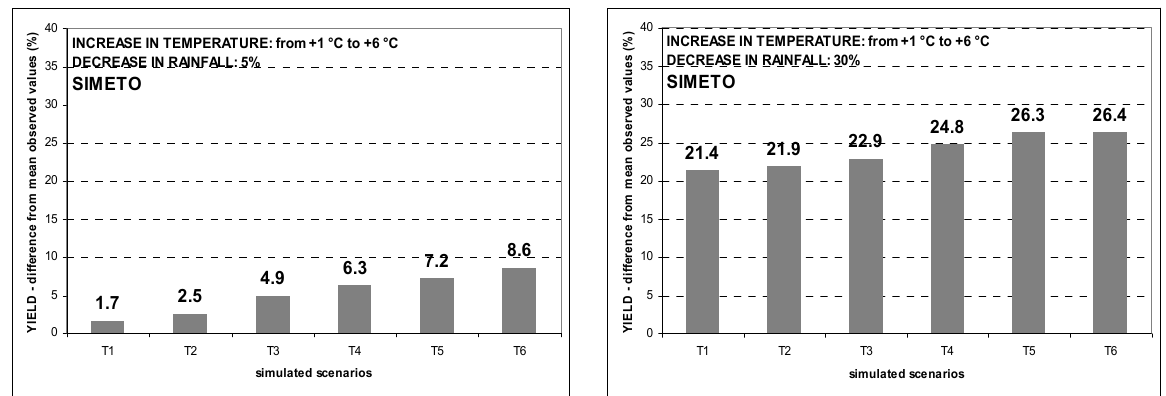
Figure 4. Percentage decline of grain yield over the period 1990–2004 at the experimental site of Benatzu for climate change scenarios characterized by increasing temperature (from +1 °C to +6 °C) and rainfall reduction by 5% ( A ) and 30% ( B ). Creso was also confirmed to be the most sensitive cultivar at Ussana site over the period 1989 to 2004, with a grain yield reduction ranging from 4.2% (scenario T1_R5) to 15.3% (scenario T6_R5) for a 5% rainfall reduction (Figure 5A), and from 26.0% (scenario T1_R30) to 33.3% (scenario T5_R30) for a 30% rainfall decrease (Figure 5B). Duilio showed grain yield declines ranging from 3.3% (scenario T1_R5) to 10.0% (scenario T6_R5) for a 5% rainfall reduction (Figure 5A), and from 25.6% (scenario T2_R30) to 29.3% (scenario T5_R30) for a 30% rainfall decrease (Figure 5B). A similar trend was observed for Simeto with a decrease of grain yield ranging from 6.7% (scenario T1_R5) to 11.2% (scenario T6_R5) for a 5% rainfall reduction (Figure 5A), and from 27.8% (scenario T2_R30) to 30.1% (scenario T6_R30) for a 30% rainfall reduction (Figure 5B). INCREASE IN TEMPERATURE: from +1 °C to +6 °C DECREASE IN RAINFALL: 30%